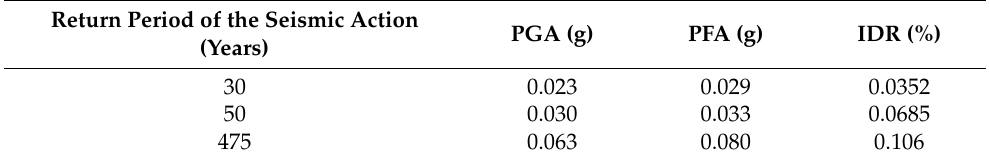
Table 11. PGA values at the site of interest, PFA values of the upper story, and maximum IDR values (among the different levels, the two directions of analysis and the 7 considered accelerograms) of unit A of the case study